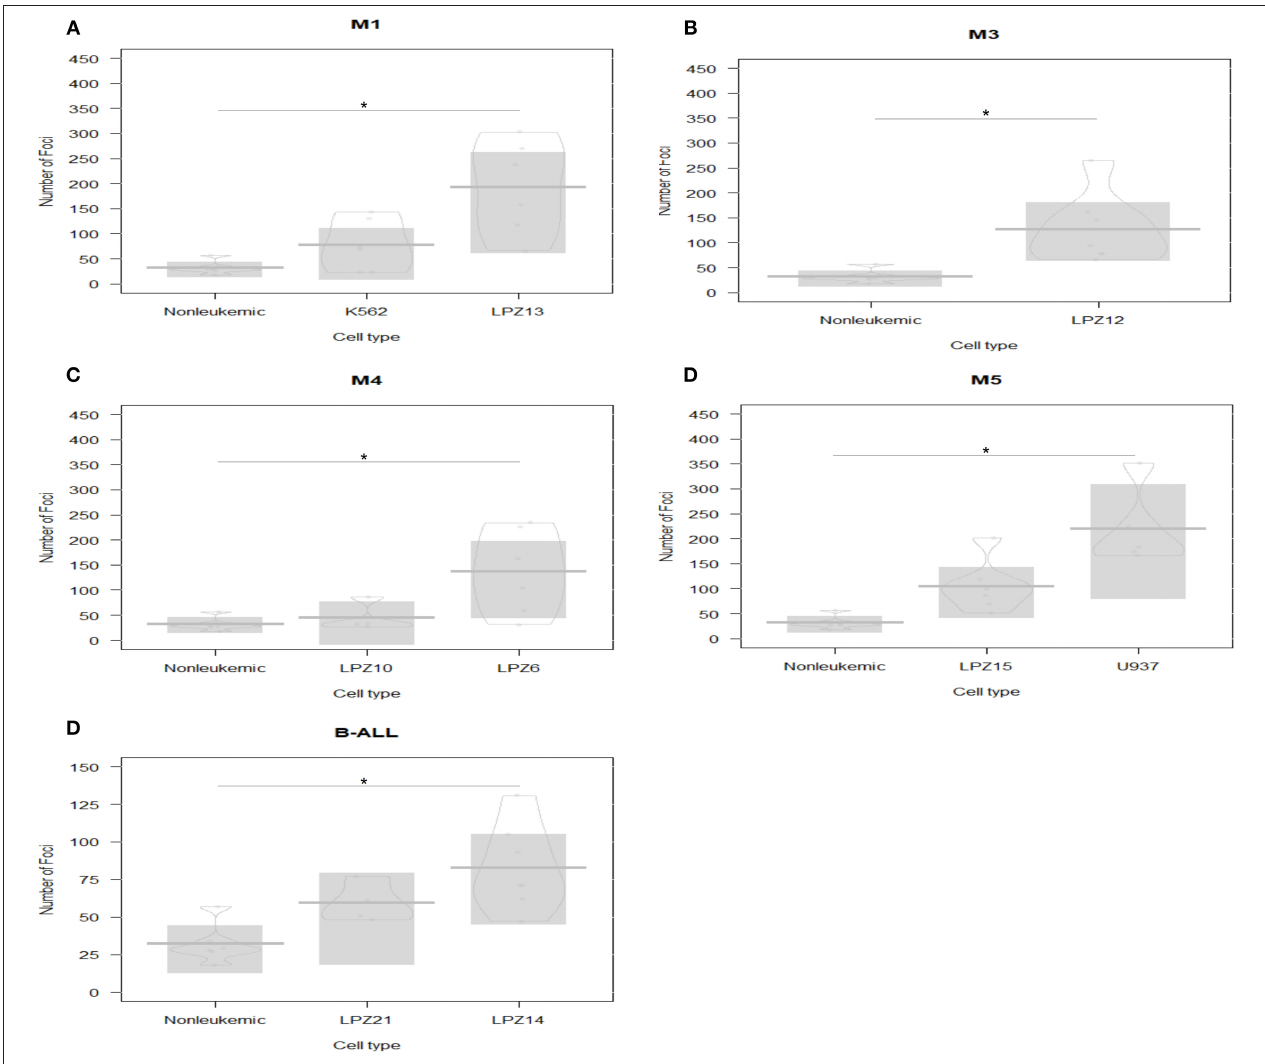
FIGURE 1 | Xenografts survival rate comparison between acute leukemia subtypes based on FAB scheme classification at 1 dpi. PDX and cell line xenografts from leukemic samples presented higher survival rates than non-leukemic xenografts. The highest rates corresponded to the less differentiated leukemia subtypes. (A) M1 samples: LPZ13, cell line K562, and non-leukemic cells. (B) M3 sample (LPZ12) and non-leukemic cells. (C) M4 samples: LPZ6 and LPZ10 compared to non-leukemic cells. (D) M5 samples: LPZ15, U935, and non-leukemic cells. (E) B-ALL samples: LPZ14 and LPZ21 and non-leukemic cells. The comparison was